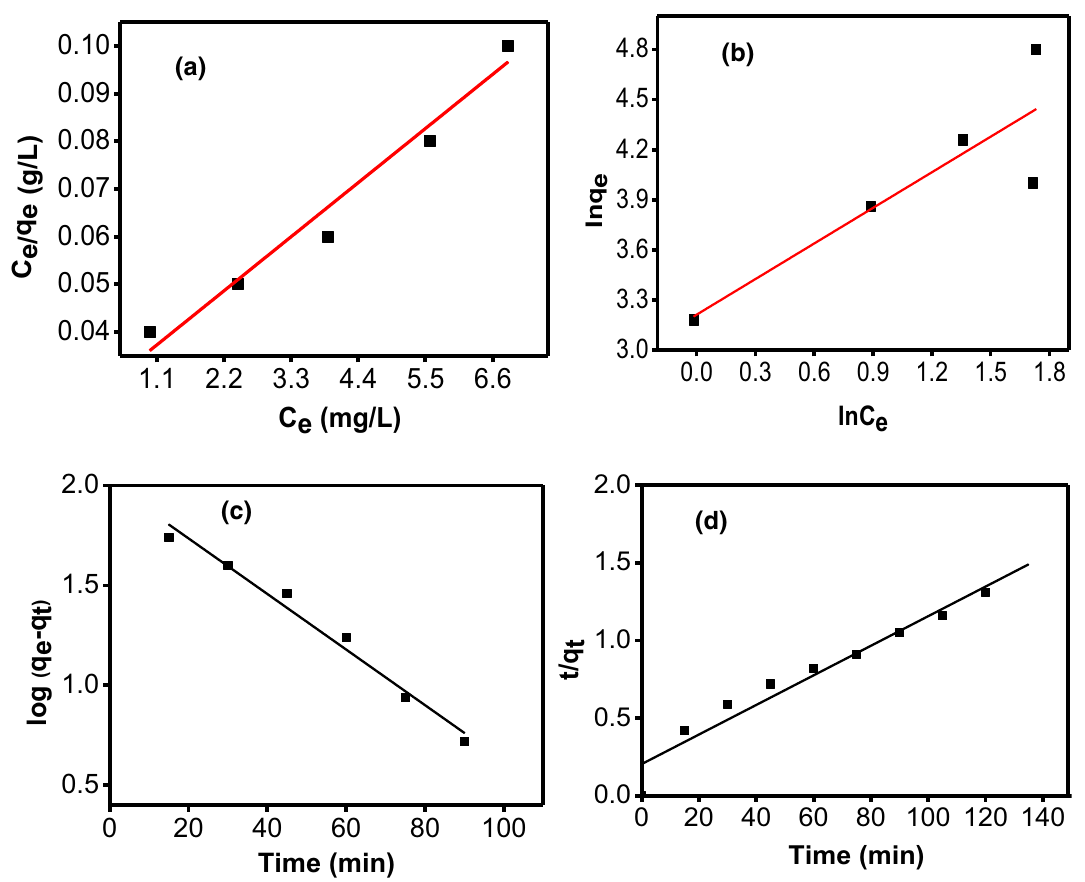
Fig. 8 Adsorption isotherm model of Pb(II) adsorption. a Langmuir; b Freundlich ([Pb] o = 25, 50, 75, 100 and 125 mg/L); c pseudo-first- order kinetic plot; d pseudo-second -order kinetic plot for the adsorp- Table 2 Parameters for the adsorption of Pb(II) by DES/H Isotherm Langmuir